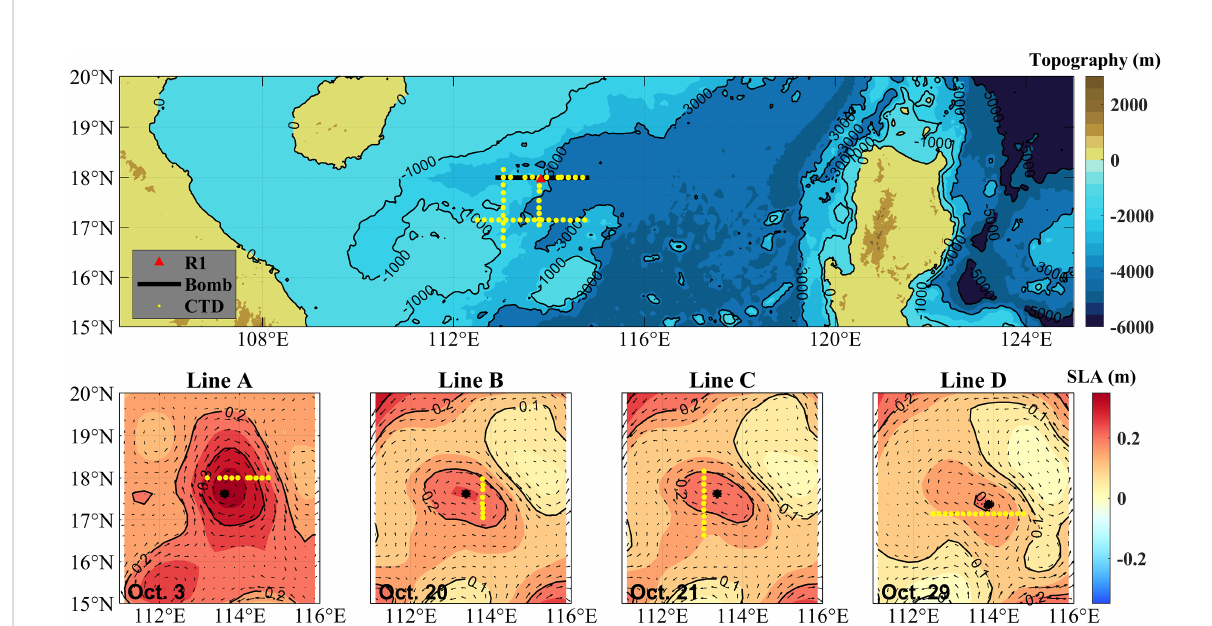
FIGURE 1 Map showing the environment con fi guration and survey stations in the EASO fi eld experiment. The topographies (unit: m) are provided by the ETOPO2 dataset (Doi: 10.7289/V5J1012Q). The black line indicates the trajectory of explosive sound sources from the west to east. The red triangle and yellow dots indicate the vertical linear array (VLA) (marked as R1) and conductivity-temperature-depth (CTD) observation stations. The positions of the CTD observation stations are shown in the lower panel, where the shaded areas indicate the daily surface level anomalies (SLAs), and vector arrows indicate daily geostrophic currents anomalies (GCAs). According to the observation dates of CTD stations, they are named lines A, B, C and D,